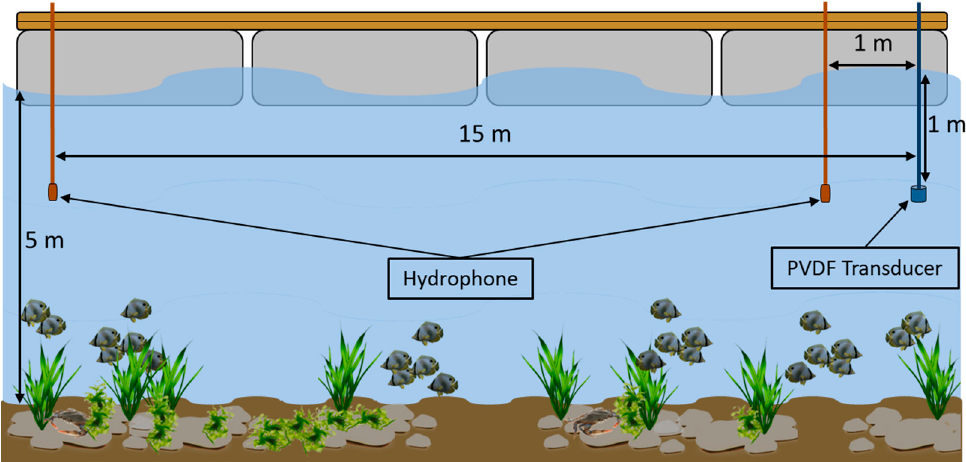
Figure 9. Field Test Experimental setup diagram carried out in floating platform in Ria de Formosa, Algarve with 5 m deep shallow water channel. The emitter transducer was fixed at 1 m deep and the hydrophone was placed at 1 and 15 m distance with 1 m deep.